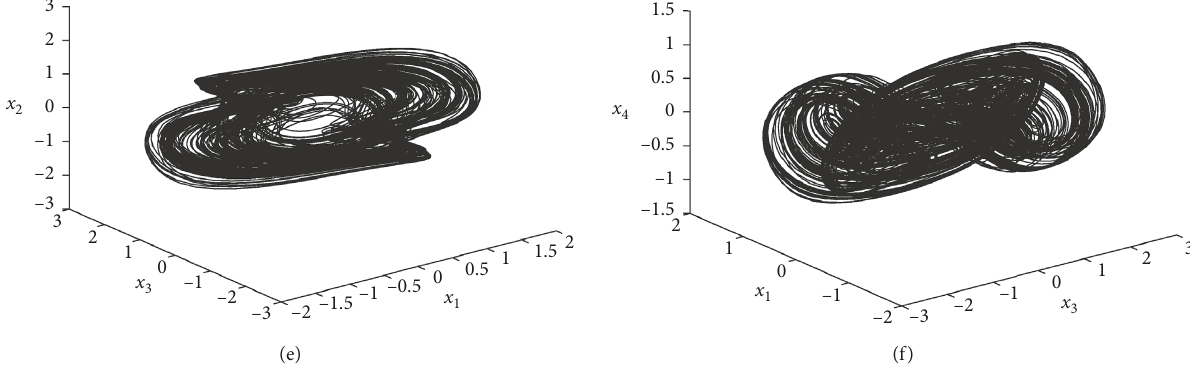
Figure 10: Chaotic motion exists when b waveform on the plane ( t, x portrait in the three-dimensional space ( x